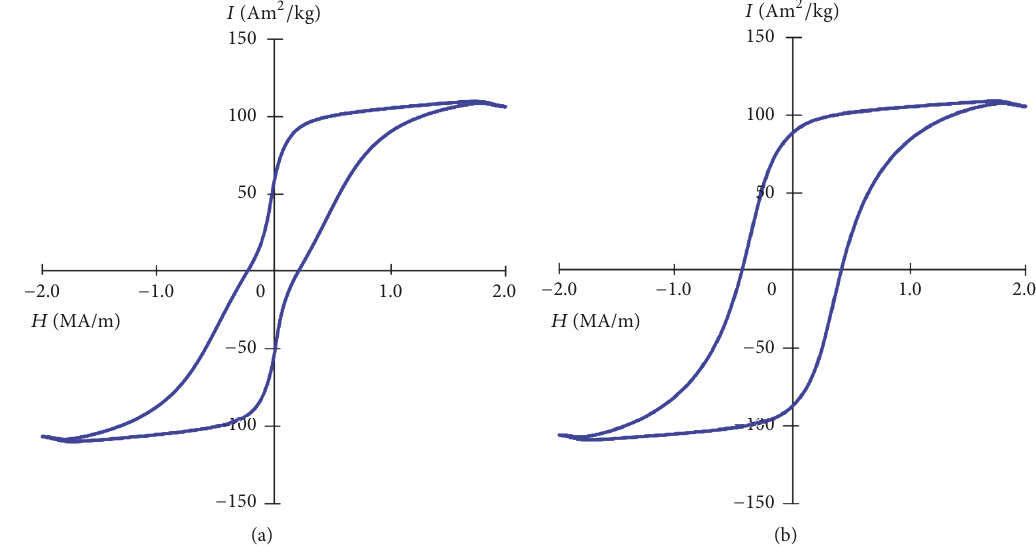
Figure 3: Hysteresis loops of Sm-Fe-N/Co-B composite powders prepared by chemical reduction using an aqueous solution of (a) 0.1mol/l and (b) 0.025 mol/l cobalt sulfate